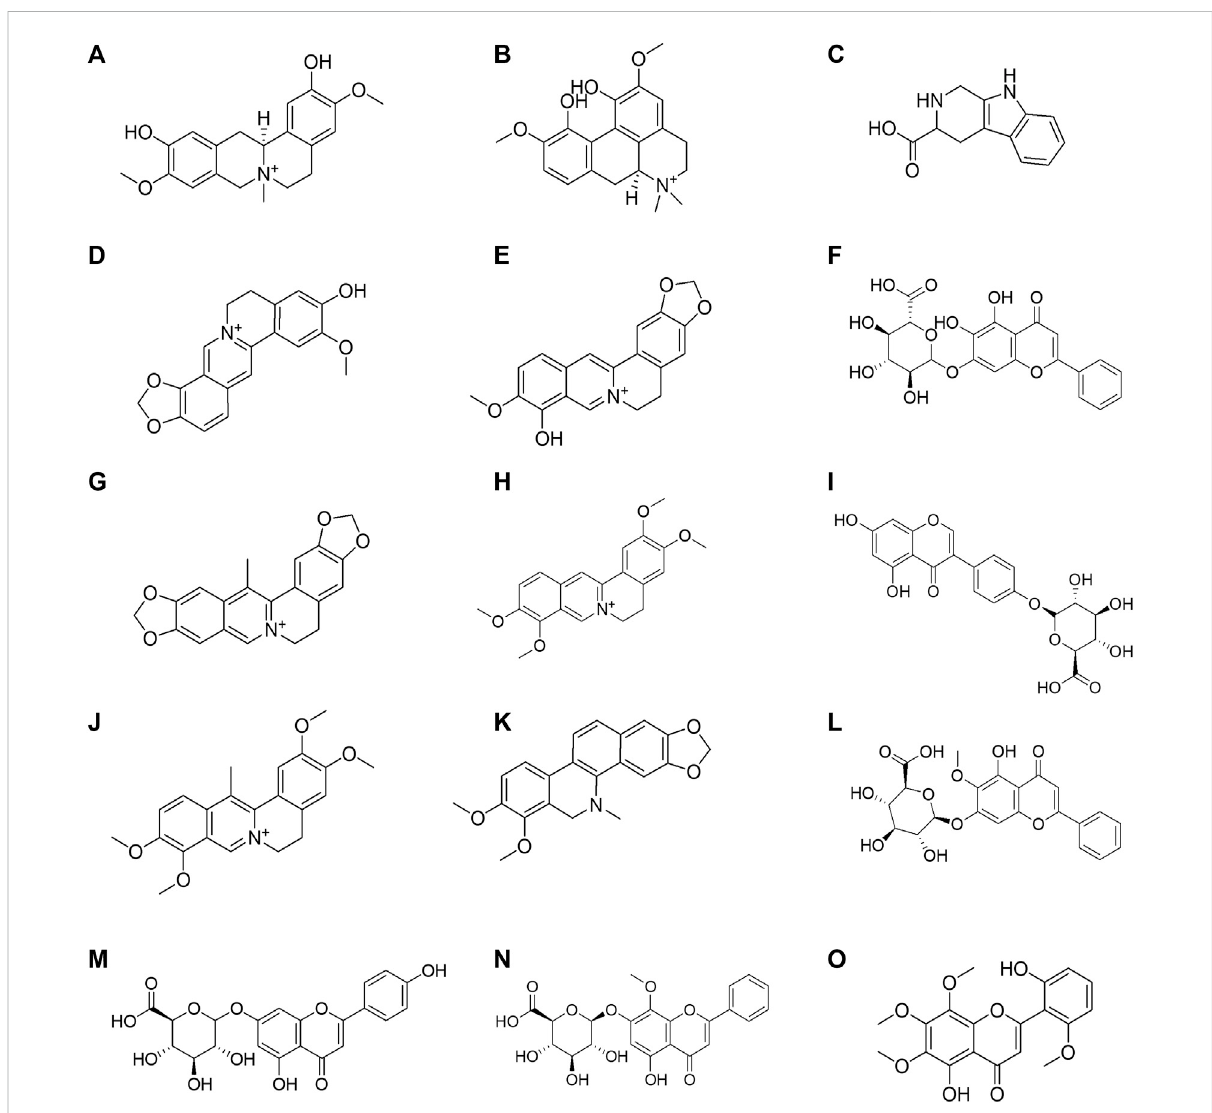
FIGURE 5 Structural formula of the 15 Huanglian Jiedu decoction (HLJDD) components dissociated from the CMs@HT22-MBs. (A) phellodendrine; (B) magno fl orine; (C) 2,3,4,9-tetrahydro-1H- β -carboline-3-carboxylic acid; (D) groenlandicine; (E) berberrubine; (F) baicalin; (G) worenine; (H) palmatine; (I) genistein 4 ′ -O-glucuronide; (J) dehydrocorydaline; (K) dihydrochelerythrine; (L) oroxylin A-7-O- β -D-glucuronide; (M) apigenin 7-O- glucuronide; (N) wogonoside; (O) skullcap fl avon